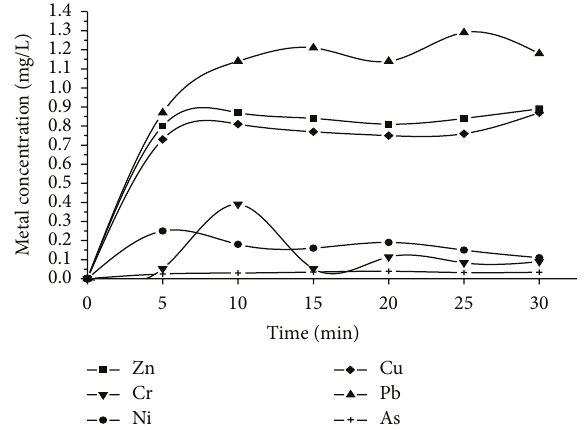
Figure 3: Leaching metals from PA during the reaction (pH = 2.5; = 0.2 g/L −1 ; [ H ] [ PA ] 0 2 O 2 0 = 5 mM; [RB4] = 100 mg/L).